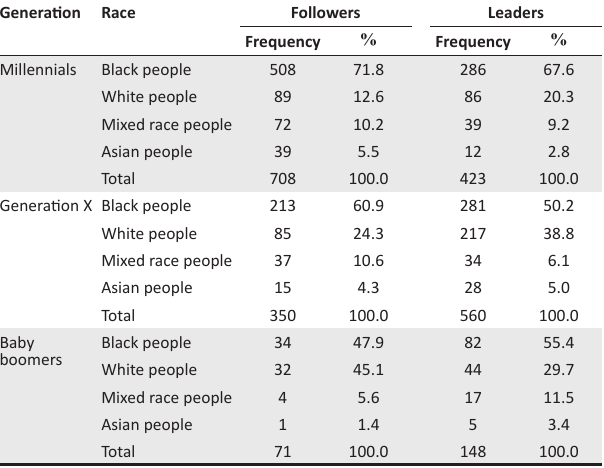
TABLE 4: Race: Followers and